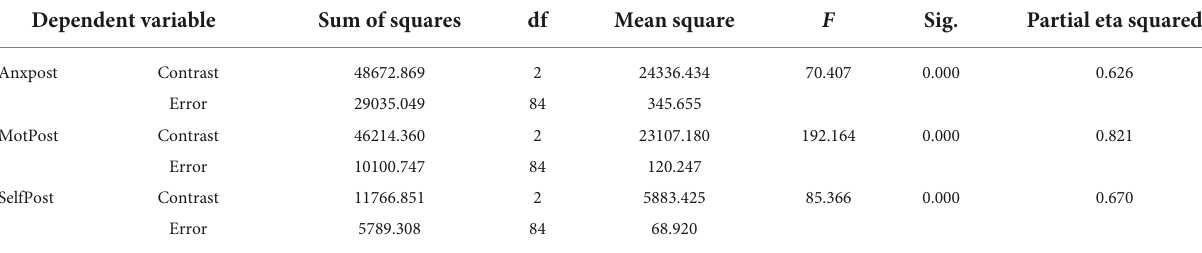
TABLE 8 Results of univariate